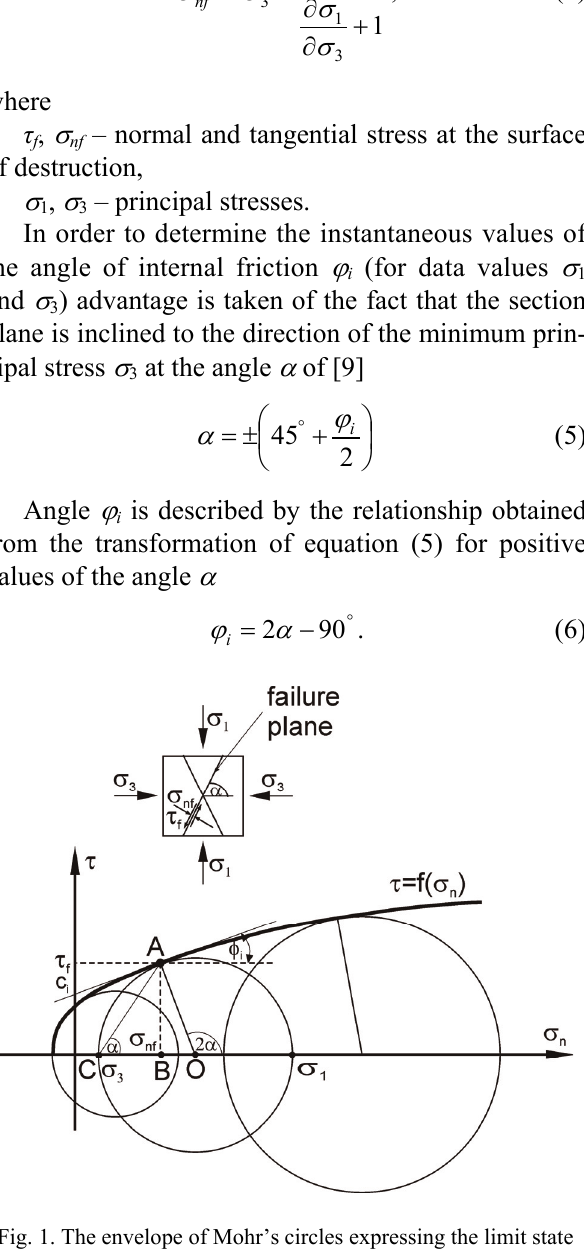
Fig. 1. The envelope of Mohr’s circles expressing the limit state of the material